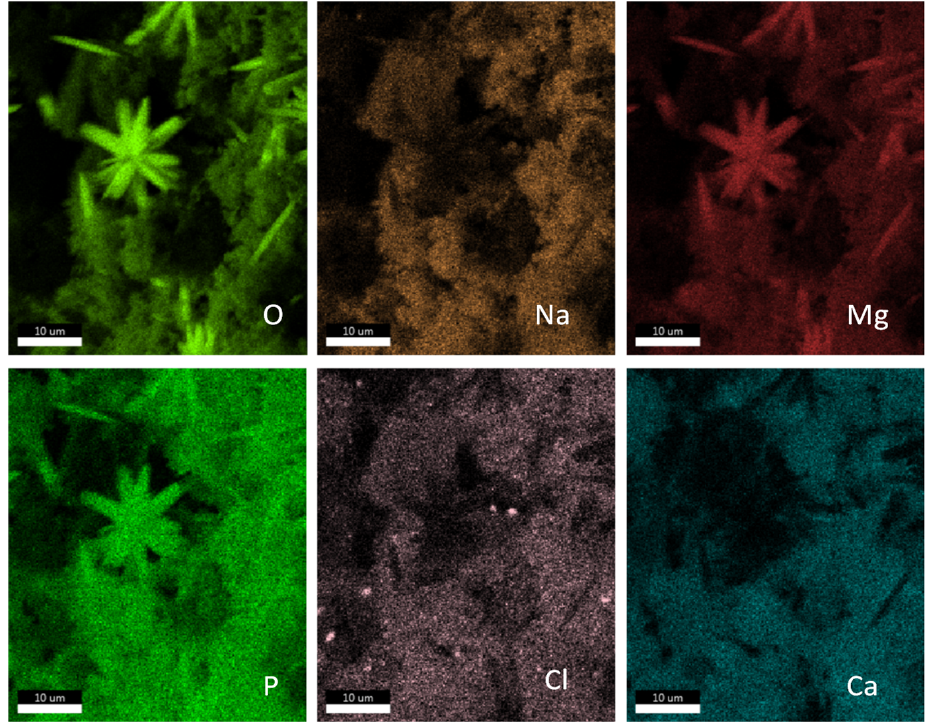
Figure 5. EDX mapping of an area with deposits of the electrode used during electromethanogenesis with M. maripaludis Mic1c10. Different elements are shown in different colors.